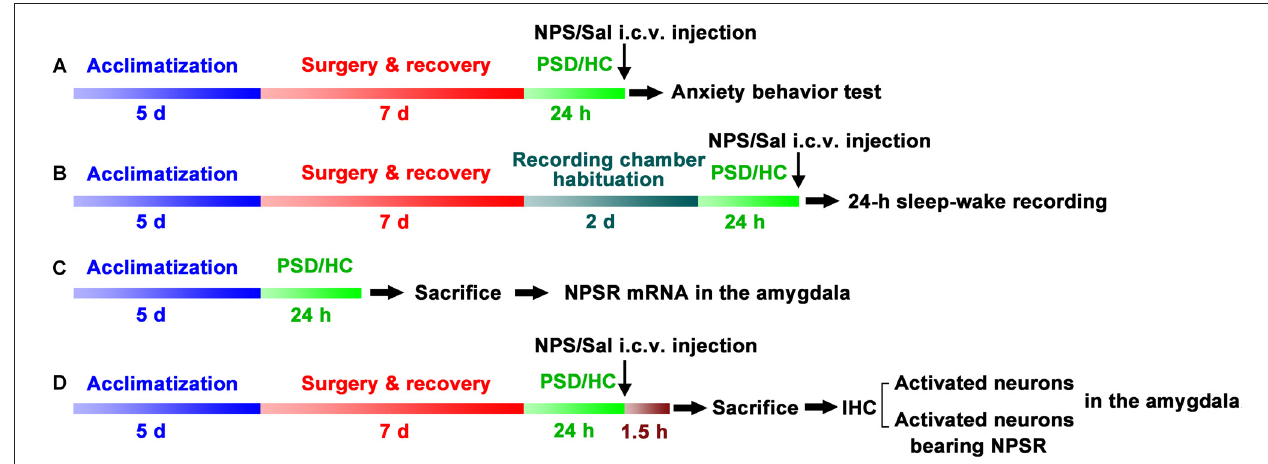
FIGURE 1 | Schematic representation of the experimental design and procedures. Anxiety-like behavior tests (A) , 24-h sleep-wake recording (B) , quantifying Neuropeptide S (NPS) receptor (NPSR) mRNA in the amygdala (C) and immunohistochemistry (IHC) of c-Fos and NPSR to detect activated neurons and determine whether activated neurons bear NPSR (D) in the amygdala were applied to investigate paradoxical sleep deprivation (PSD)-induced anxiety-like behaviors and the effect of centrally administered NPS on them. Rats in experiments (A–D) except home cage control (HC) ones were subjected to PSD for 24 h using the modified multiple platform method (MMPM). NPS or saline (Sal) i.c.v. administration was carried out 5 min before anxiety-behavior tests (A) and sleep-wake recording (B) . In experiment (C) , bilateral amygdala was harvested immediately after the rats were sacrificed to detect NPSR mRNA using RT-qPCR. Animals in experiment (D) were sacrificed following NPS or Sal i.c.v. administration, and their brains were sectioned and immunostaining was performed to detect NPS activated neurons in the amygdala and determine whether these neurons express